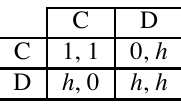
Table 3. Payoff matrix of the Stag Hunt